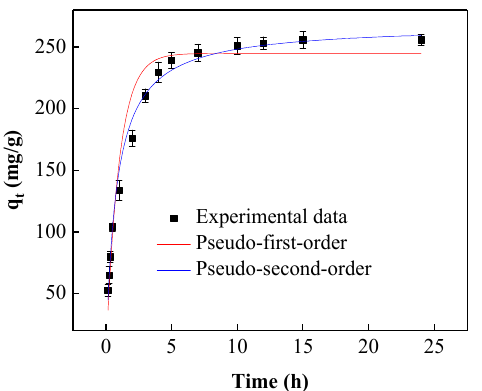
Figure 6. Adsorption kinetics of RB5 onto Ct-PAC-HDA beads (30 mg of beads, 200 mL of 200 mg / L of RB5, pH=4, 25 °C, 24 h).